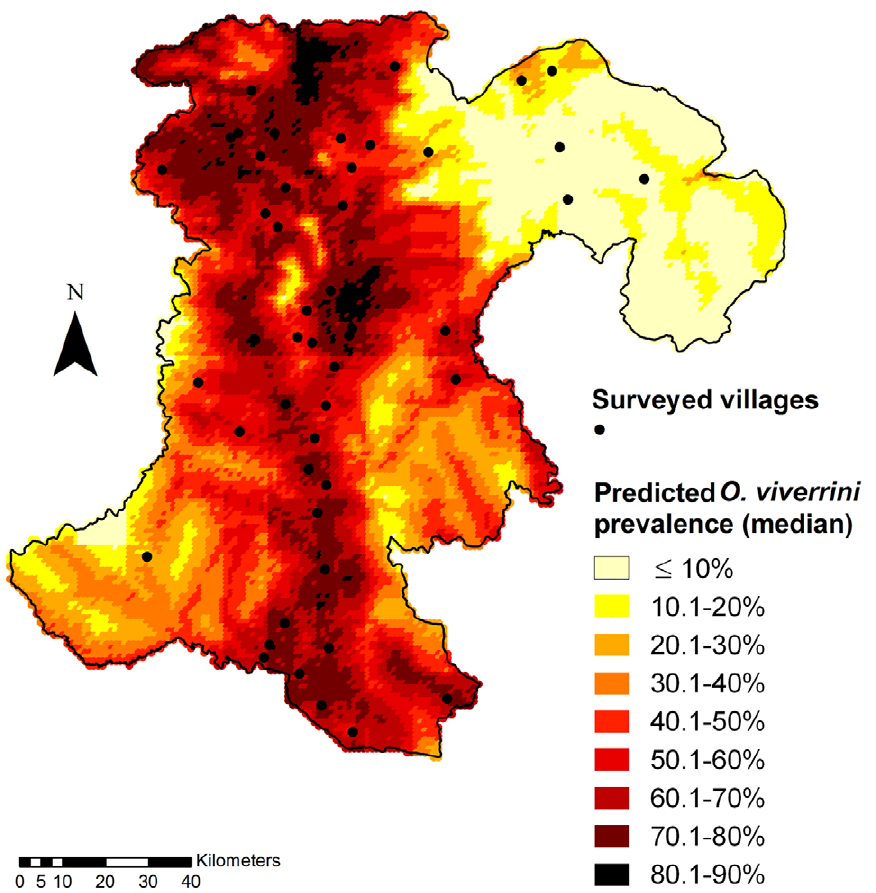
Figure 2. Map of the predicted prevalence (median) of O.viverrini infection in Champasack province, southern Lao PDR. doi:10.1371/journal.pntd.0001481.g002 Figure 3. Error coefficient of the predicted O.viverrini prevalence (a) and location-specific random effects (b). The error coefficient is the ratio of the predicted prevalence median over its standard deviation (SD). Darker zones indicate higher uncertainty of the predictive model.